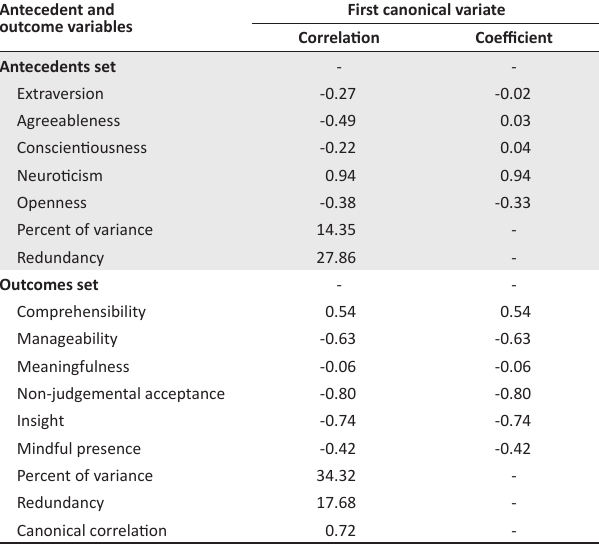
TABLE 3: Results of canonical analysis: Big 5 personality traits, mindfulness and sense of coherence. Antecedent and outcome variables